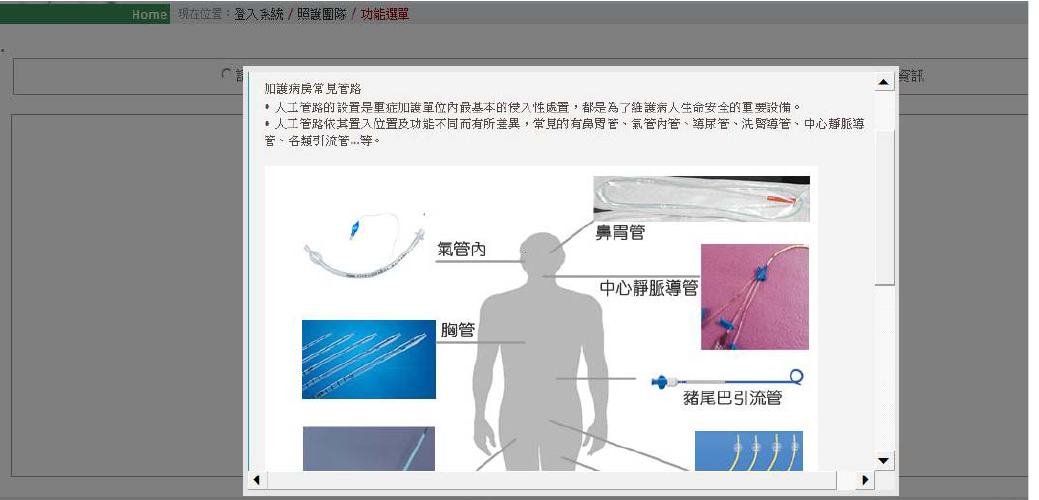
Figure 2. ICU-related information: introduction of commonly used tubes. Note: The ICU-SSS showed the relevant description of commonly tubes for patients’ care, started from upper right hand are nasogastric tube, central venous catheter, Pig-tail drainage tube, chest tube, intratracheal tube.